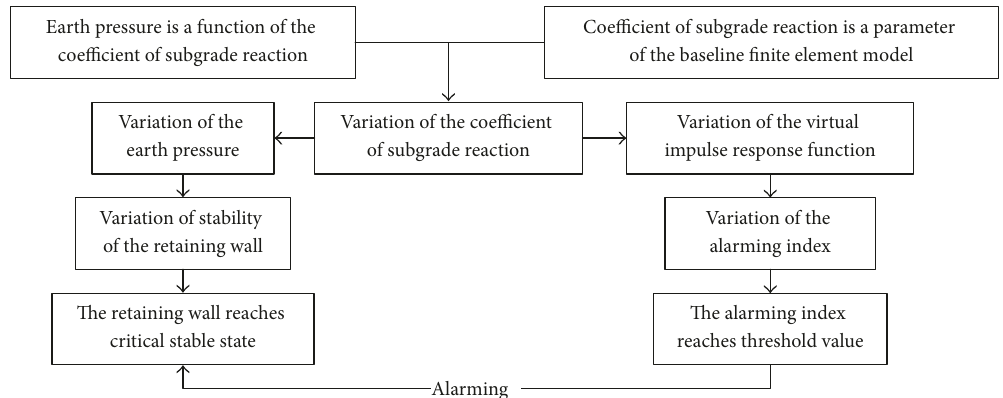
Figure 6: Principle of the damage stability alarm for the retaining wall.